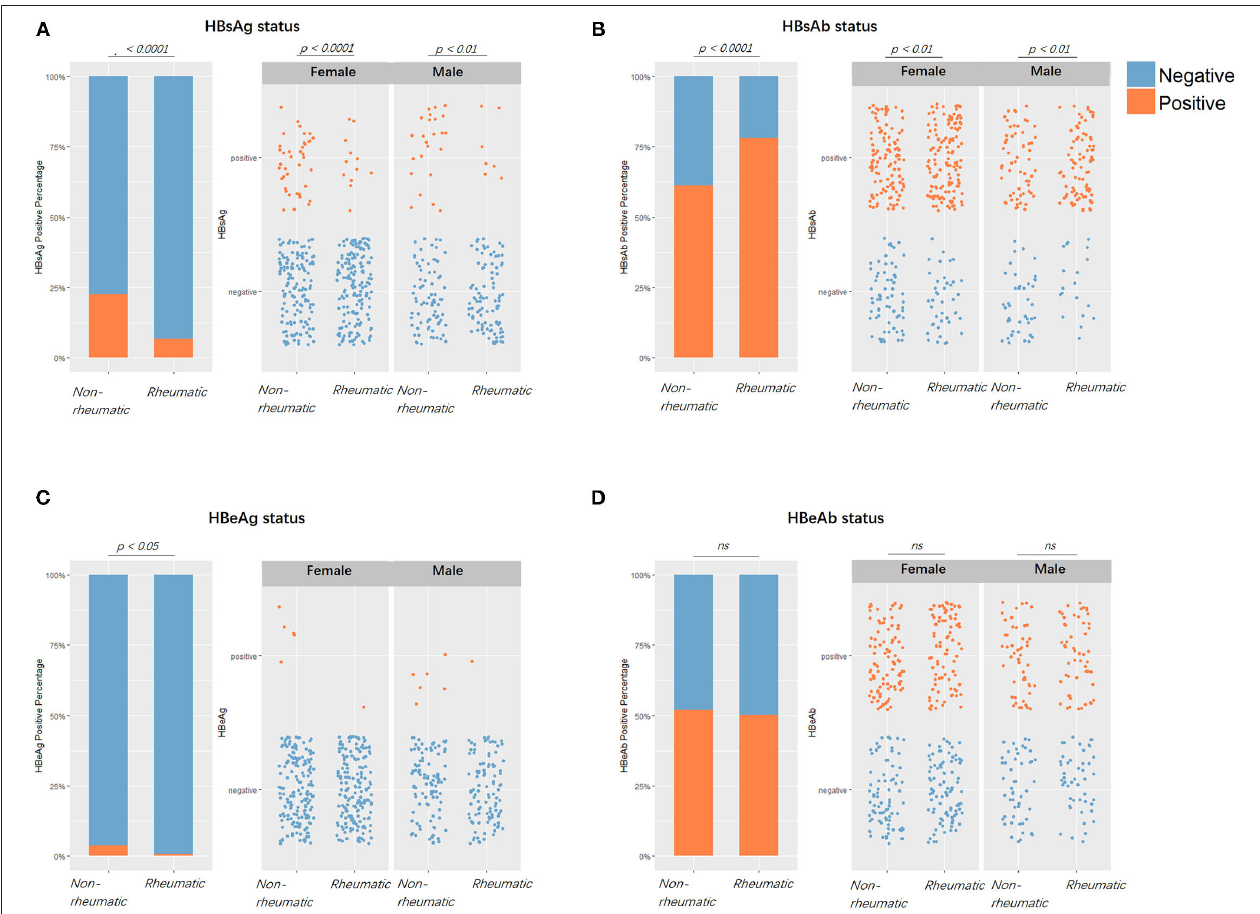
FIGURE 3 | Viral markers positivity rates comparisons between patients with rheumatic and non-rheumatic diseases. (A) From left to right, the first figure showed HBV surface antigen (HBsAg) positive/negative status percentages between the rheumatic and non-rheumatic groups. Blue stood for negative serological results, while orange stood for positive results. The second and third figures showed subgroup results of females and males. Each point represented one patient. From (B–D) , the positive/negative status of HBsAb, HBeAg, and HBeAb in patients from the two groups along with gender subgroups were laid out in the same sequence as in (A) .